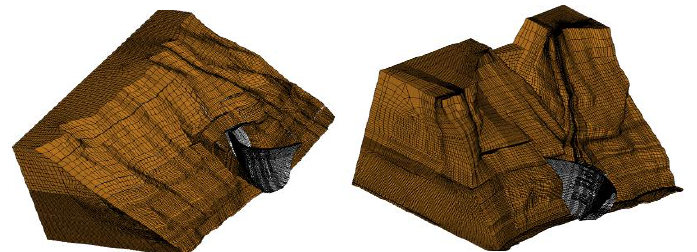
Figure 13. Three-dimensional finite element simulation of left and right banks.